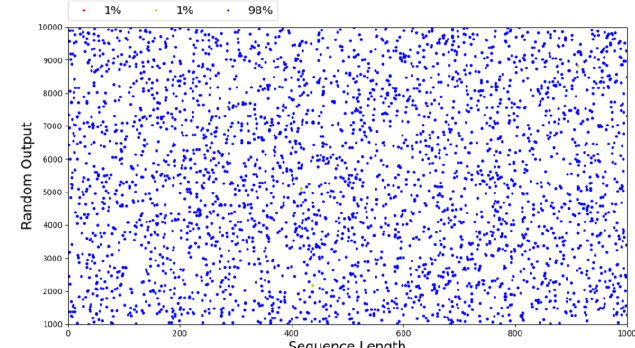
Fig. 18. Random number generation output frequency scatter plot with with-seed pre-optimisation high noise scenario